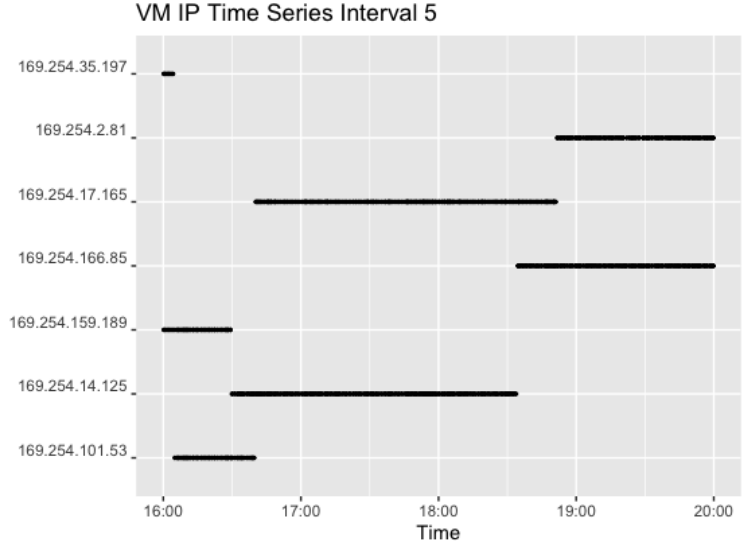
Figure 14. Interval 5 IP Distribution.